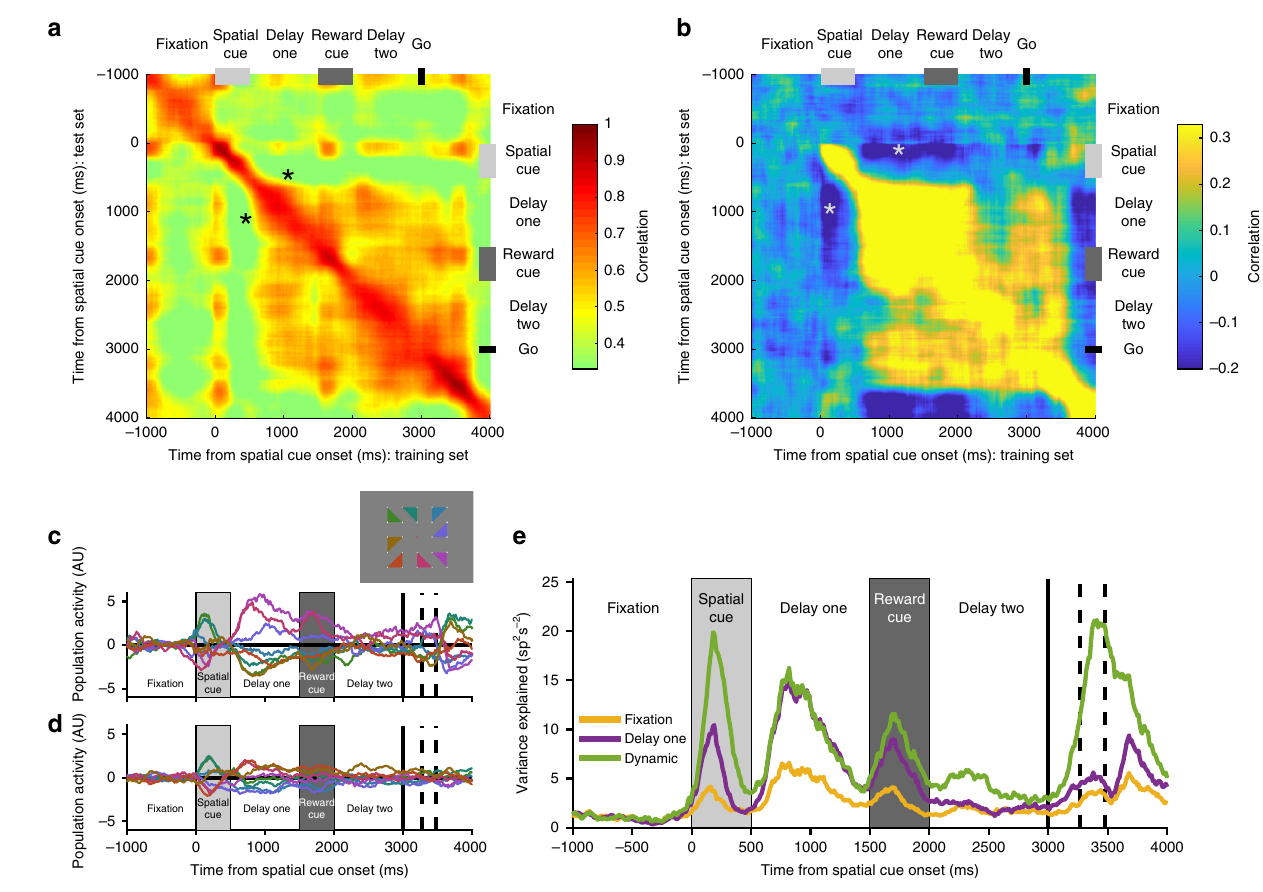
Fig. 5 VLPFC high time-constant population reverses its spatial coding between cue presentation and the subsequent delay. a Within-condition correlation of neural fi ring across time for SR-trials (Methods). All bins are positively correlated with each other, suggesting neural fi ring is stable across time. Note positive correlation between cue period and delay (asterisk). b Within-condition correlation analysis where activity for each neuron was demeaned across each of the spatial locations (Methods). There now exists a negative correlation between the time of the spatial cue presentation and delay-one (asterisk). c – d Reversal of VLPFC high time-constant spatial tuning between cue and delay. A mnemonic subspace was de fi ned with time-averaged delay-one activity. The across-trial fi ring for each condition was projected back onto the fi rst ( c ) and second ( d ) principal axes of this subspace. While the conditions remain well-separated on both principal axes during delay-one, the subspace does not generalise well into delay-two as activity from the different conditions converges. At the time of the spatial cue, the conditions appear separable, but in the reverse con fi guration from that during the delay. The inset shows the geometric location of each spatial location that appeared on the screen. e The stimulus variance captured by three different subspaces is displayed. The fi xation subspace is de fi ned by time-averaged activity in the 1000 ms before cue presentation. This should represent a chance level amount of variance explained. The delay-one subspace is de fi ned by time-averaged activity from 500 to 1500 ms after cue presentation. The dynamic subspace is de fi ned separately at each individual time point. The dynamic subspace explains a much greater amount of variance during the cue period, illustrating that there is little consistency in the activity patterns between spatial cue and the delay epochs. However, the delay-one subspace captures as much variance as the dynamic subspace during delay-one, suggesting the VLPFC high-tau population activity has settled to a stable state by this